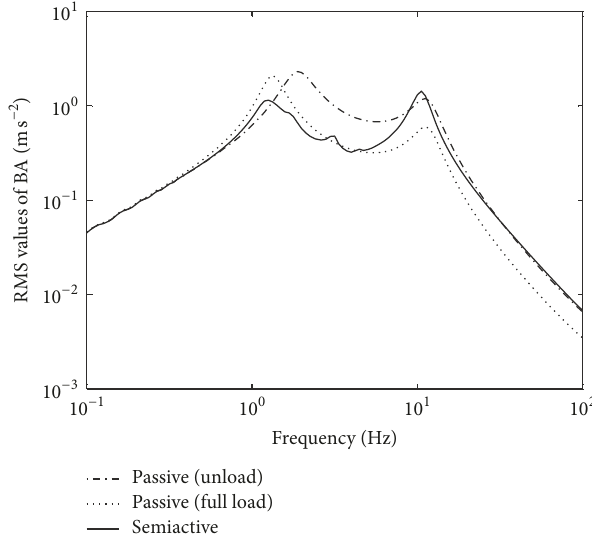
Figure 5: Frequency responses of body